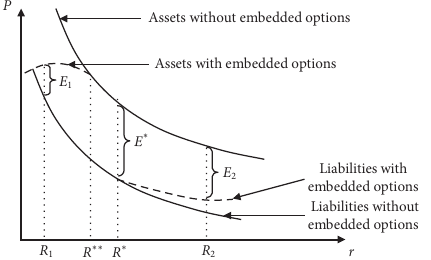
Figure 5: Value-interest rate curve of bank assets and